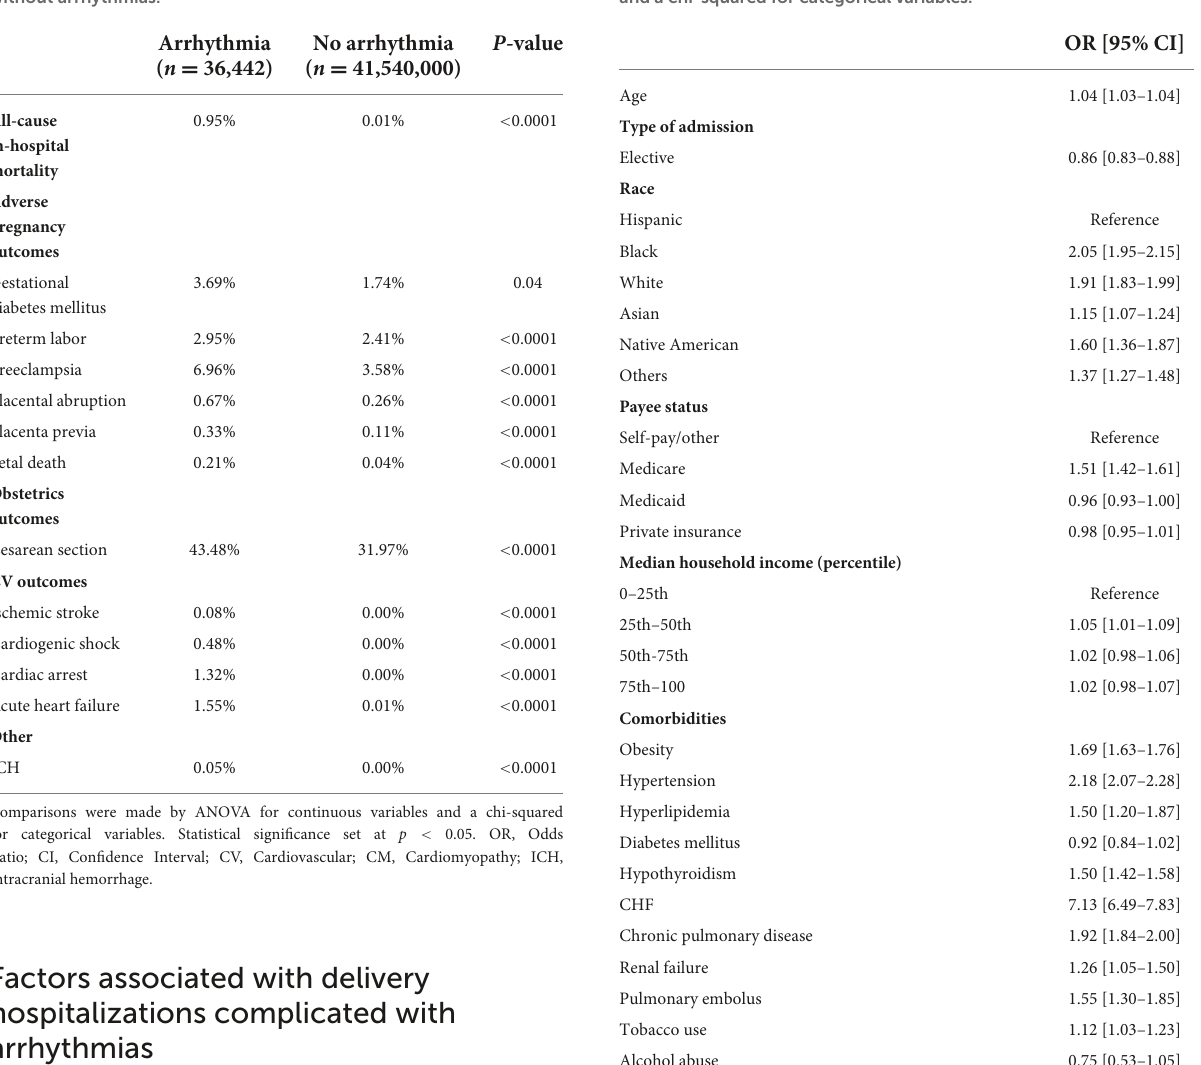
TABLE 4 Comparisons were made by ANOVA for continuous variables and a chi-squared for categorical